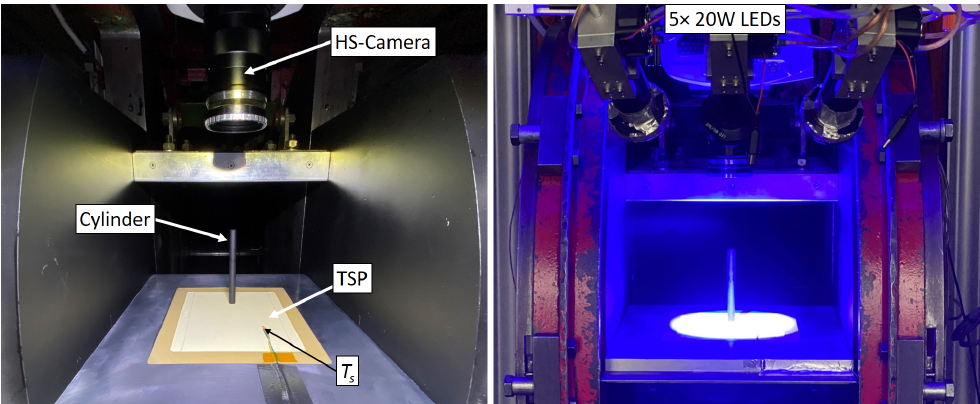
Figure 4. Experimental setup and test equipment for the high-speed TSP measurements in the wind tunnel